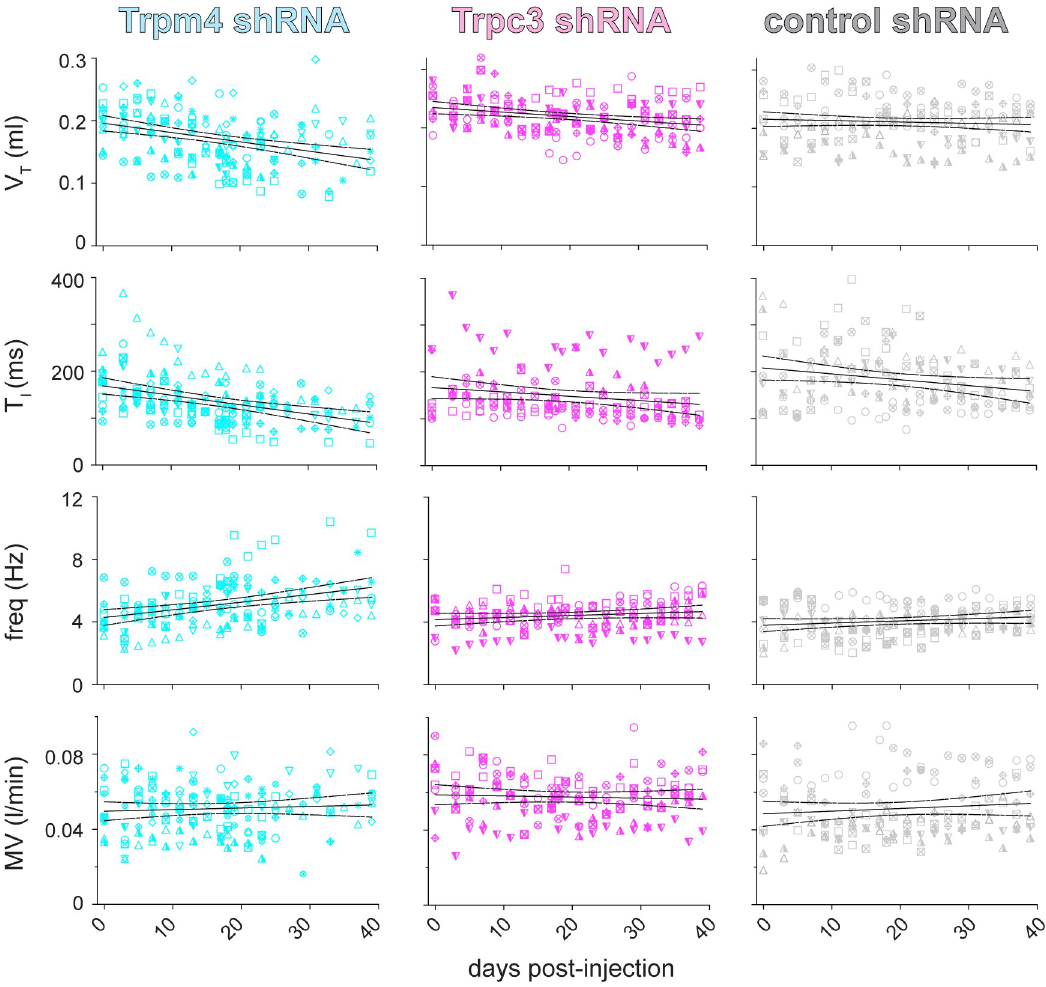
Fig 6. Longitudinal study of breathing after shRNA injections in three mouse cohorts. Breathing measurements in awake adult CD-1 mice after shRNA injection targeting Trpm4 (left, cyan), Trpc3 (middle, magenta), and a nontargeting control sequence (right, gray). Rows from top to bottom show V T , T I , frequency, and MV. Each animal was assigned a unique symbol (circle, square, triangle, hexagon, plus sign, asterisk, and variations on those symbols), which tracks the breathing measurements for that animal during the postinjection observation period. Best-fit lines and the 95% confidence intervals are shown. The number of points in the left column (Trpm4) decreases as animals died of respiratory failure starting at the bin for days 25–30. Primary data can be found in the Supporting information (S1 Data). shRNA, short hairpin RNA; Trp, transient receptor potential.